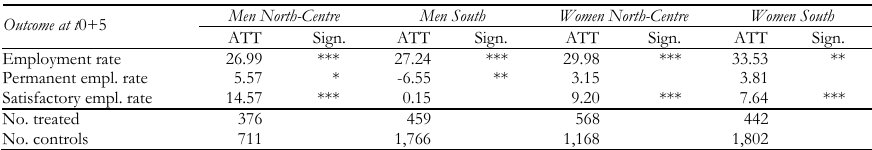
Estimates of the causal effects, 2005-06 sample, by gender and area (a)